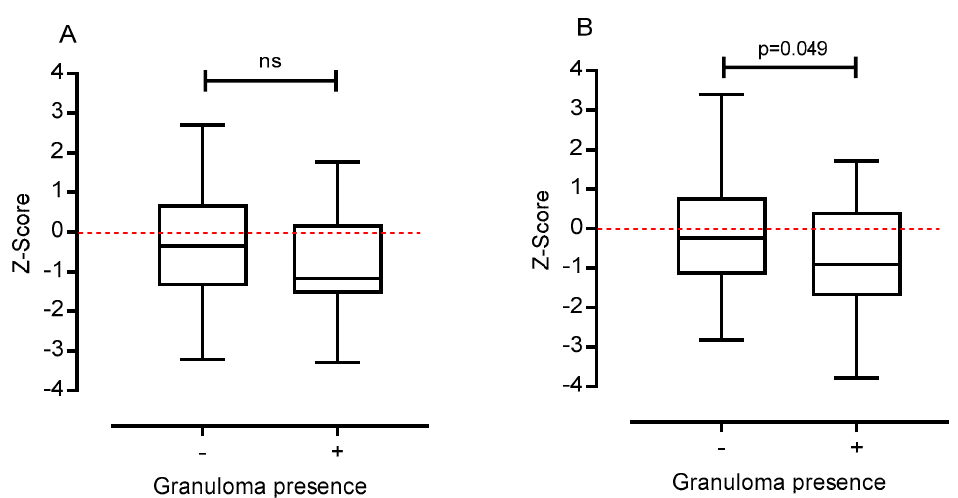
Figure 2. Anthropometric measurements at diagnosis of 79 children with Crohn’s disease; z-score distribution of height ( A ) and weight ( B ) measurements of patients who were granuloma negative or positive ns = not significant